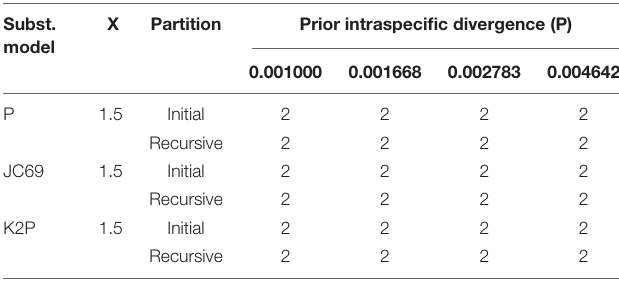
TABLE 2 | The number of putative species recognized by Automatic Barcode Gap Discovery (ABGD) analyses of complete plastome sequences using three distance